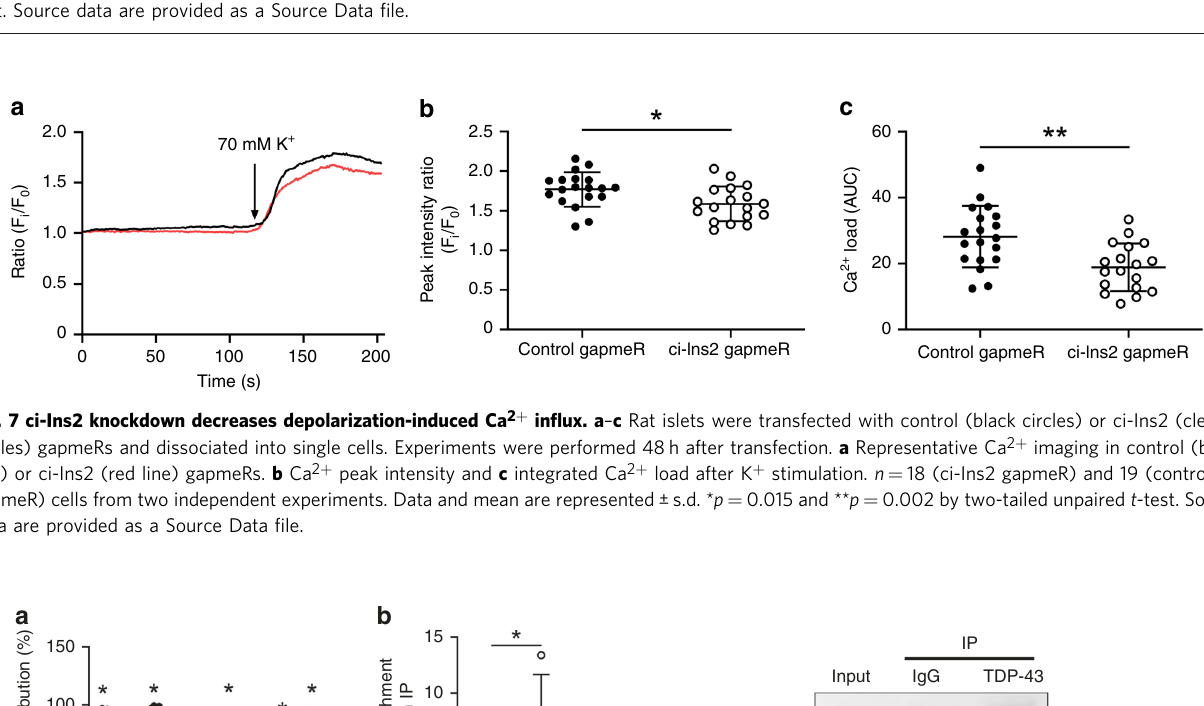
Fig. 6 ci-Ins2 and ci-INS inhibition affect islet gene expression. a Downregulated and upregulated genes (blue gene names) related to insulin secretion in ci-Ins2 knockdown rat islet cells (modi fi ed KEGG pathway map 04911, https://www.genome.jp/kegg/pathway.html). Genes were selected from the differential gene expression and KEGG pathway enrichment analyses of ci-Ins2 vs. control gapmeR rat islet RNA-sequencing data ( n = 3, p < 0.05, GEO accession GSE134699). b Expression of indicated genes normalized to Hprt1 , measured by qPCR, in ci-Ins2 gapmeR transfected rat islet cells relative to control. n = 5 ( Atp1a1 and Syt7 ) and six independent experiments. c , d Expression of indicated genes normalized to HPRT1 and PPIA , measured by qPCR, in ( c ) ci-INS gapmeR 1 ( n = 6 independent experiments) or ( d ) ci-INS gapmeR 2 ( n = 8 independent experiments) transfected human islet cells relative to control. e 2 h newly transcribed mRNA levels of indicated genes normalized to Hprt1 , measured by qPCR, in ci-Ins2 gapmeR transfected rat islet cells relative to control. n = 3 independent experiments. f 2 h newly synthesized insulin protein levels, measured by ELISA, in ci-Ins2 gapmeR (clear circles and squares) transfected rat islets relative to control (black circles and squares) and treated (or not) with AHA. n = 3 independent experiments. b – f Data and mean are represented ± s.d. blue circles: p < 0.05 by two-tailed one-sample t -test. * p = 0.019 and ** p = 0.001 by one-way ANOVA and Tukey post hoc test. Source data are provided as a Source Data fi le.